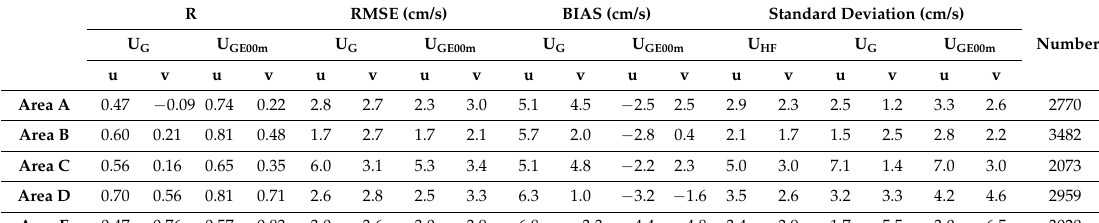
Table 3. MAB data in the same form as for Table 2. Statistical measure comparisons are now between collocated in situ CODAR HF radar measured current velocity U HF and either GlobCurrent U G (Geostrophic only) or U GE00m (Geostrophic + surface Ekman). Num is number of observations. The selected focus areas A–E in the MAB are shown as in Figure 1. R RMSE (cm/s) BIAS (cm/s) Standard Deviation (cm/s)